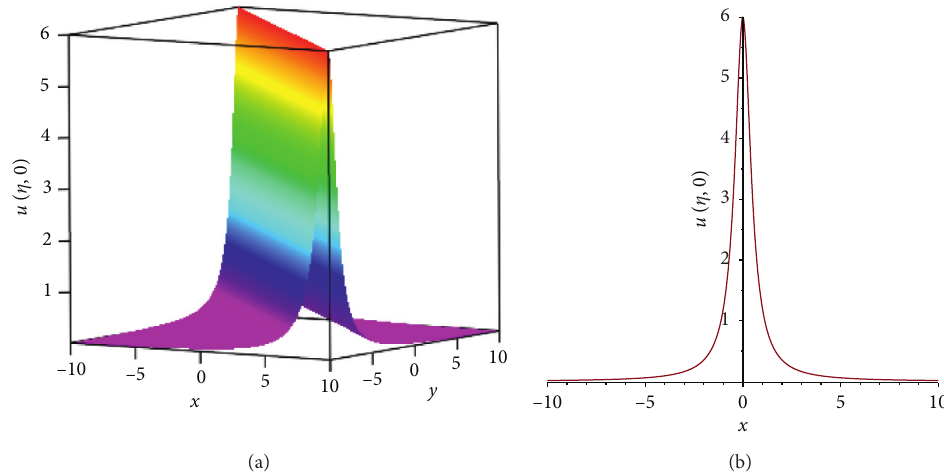
Figure 1: A single algebraic gravity solitary wave at t � 0. (a) Space diagram. (b) Planar